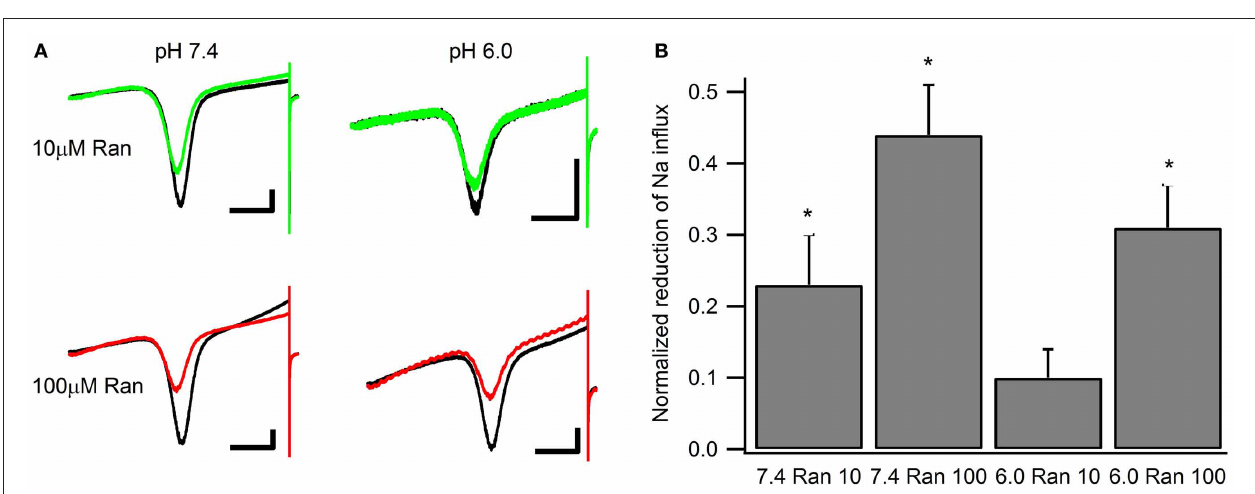
FIGURE 6 | Late Na + current during 50ms depolarization to − 10mV from a − 130mV holding potential. Representative traces from recordings at extracellular pH 7.4 and 6.0 are shown in (A) Inset scale bars are 40 pA. (B) Late I Na measured at 45–50ms normalized to peak